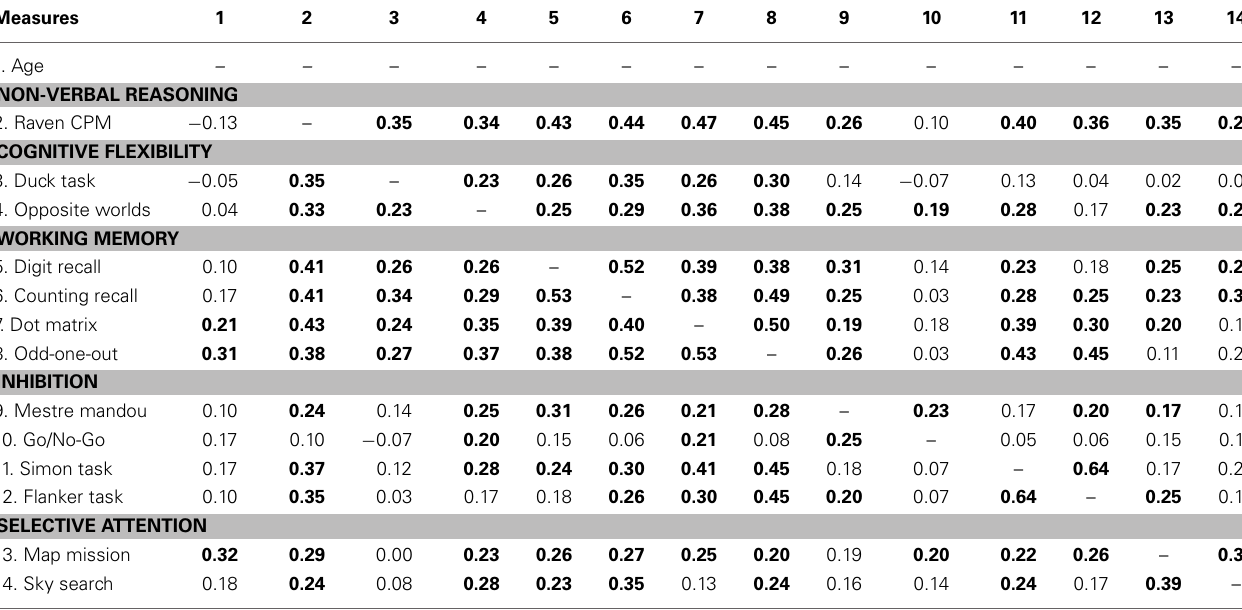
Table 4 | Correlations between age, non-verbal reasoning and executive functioning using Pearson’s correlation coefficients ( N = 106). Measures